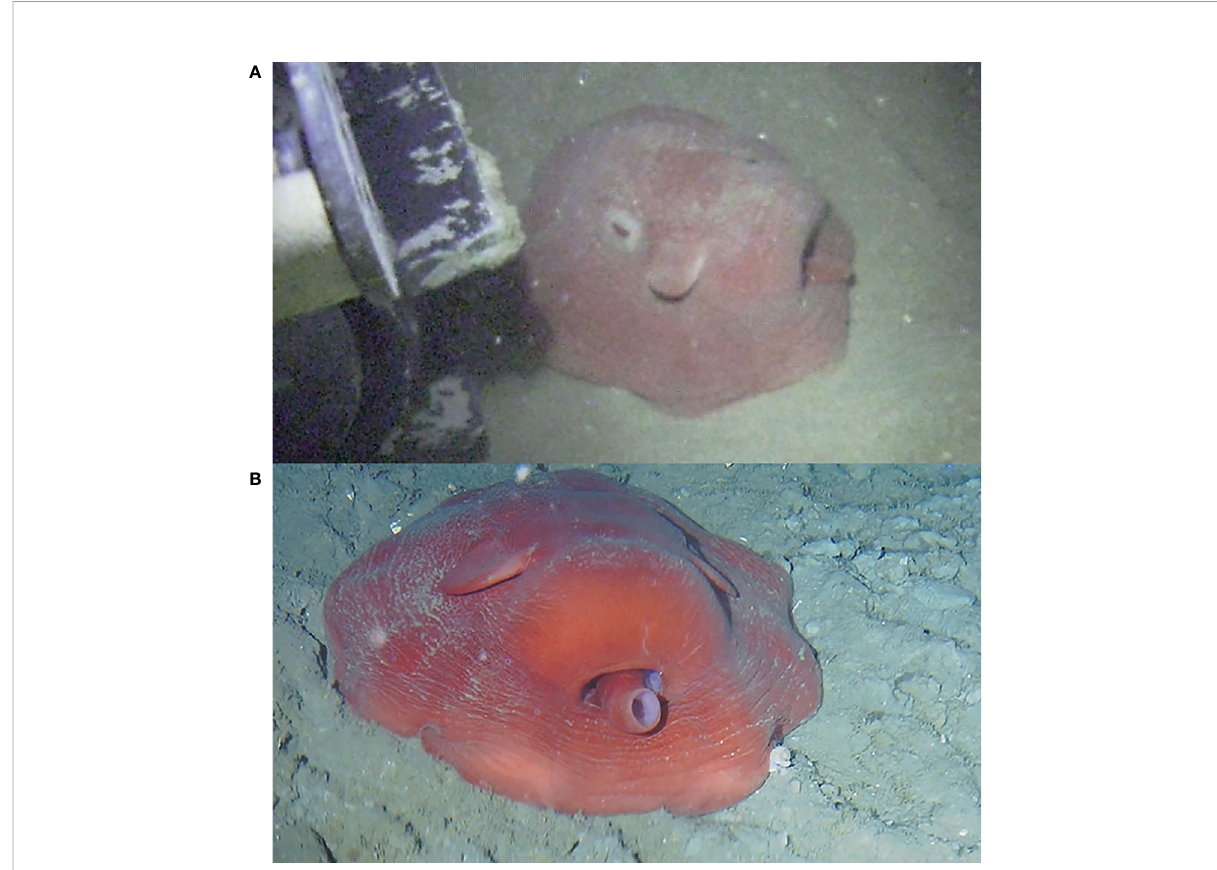
FIGURE 9 Octopus resting on the seabed in a fl at-spreading position, on top of the crawler ’ s tracks. (A) Note the opened eyes during the octopus ’ interaction with the crawler ’ s caterpillars (image taken on November 24 2016). (B) Note the closed eyes while the crawler remained close to the octopus (image taken on September 13